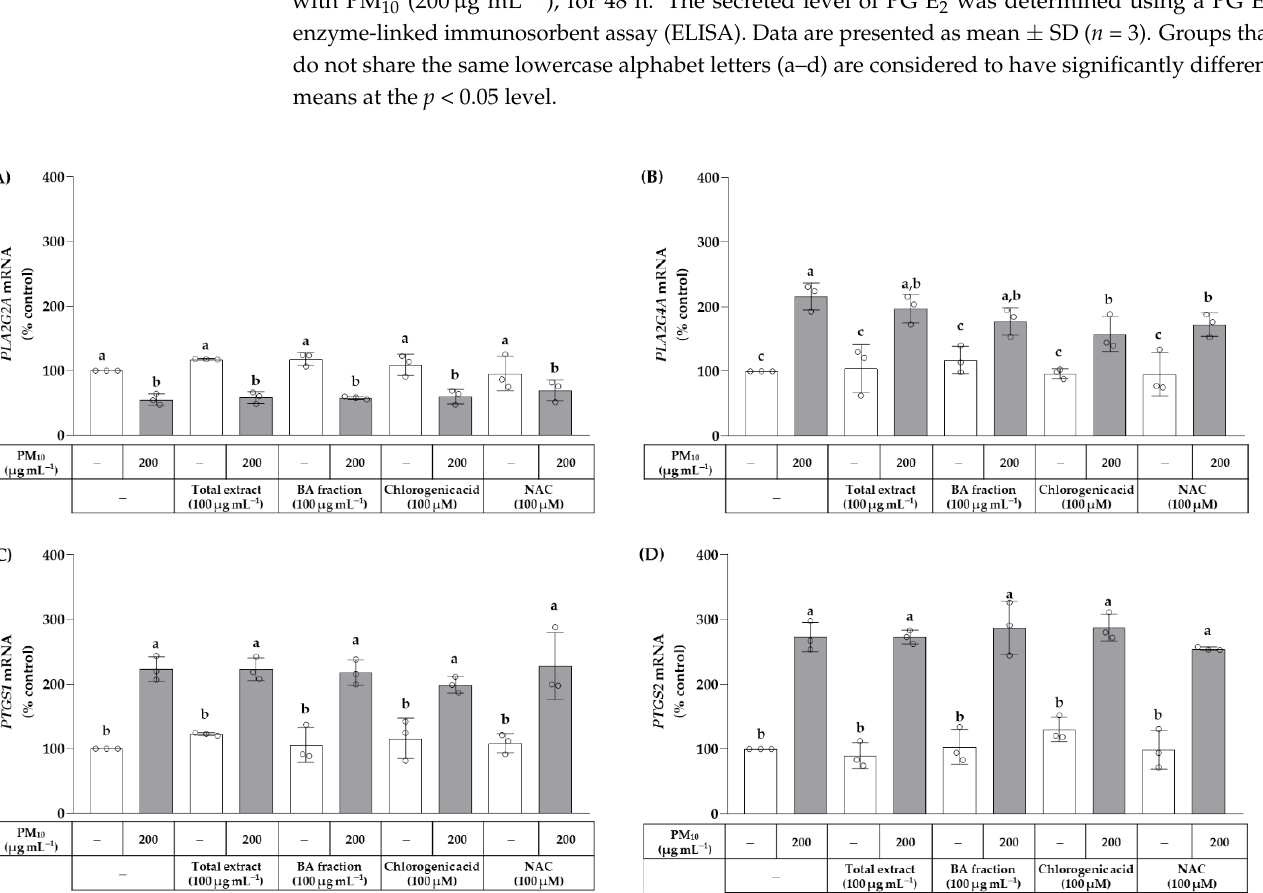
Figure 8. Effects of the total OJ extract, its BA fraction, chlorogenic acid, and NAC on the mRNA expression levels of phospholipase A2 group IIA ( PLA2G2A ) ( A ), phospholipase A2 group IVA ( PLA2G4A ) ( B ), prostaglandin-endoperoxide synthase 1 ( PTGS1 ) ( C ), prostaglandin-endoperoxide synthase 2 ( PTGS2 ) ( D ), prostaglandin E synthetase 1 ( PTGES1 ) ( E ), and prostaglandin E synthetase 2 ( PTGES2 ) ( F ) in HaCaT keratinocytes exposed to PM 10 . Cells were treated with the total extract (100 μg mL −1 ), BA fraction (100 μg mL −1 ), chlorogenic acid (100 μM), and NAC (100 μM), alone or in combination with PM 10 (200 μg mL −1 ), for 24 h. The mRNA expression level of each gene was ana- lyzed by the quantitative reverse transcriptase-polymerase chain reaction (qRT-PCR) and normal- ized to that of glyceraldehyde 3-phosphate dehydrogenase ( GAPDH ). Data are presented as % of control (means ± SD, n = 3). Groups that do not share the same lowercase alphabet letters (a–c) have statistically different means at the p < 0.05 level. The effects of the total OJ extract, BA fraction, chlorogenic acid, and NAC on the pro- tein expression levels of cPLA2 and its phosphorylated active form (phospho-cPLA2) were examined by Western blotting. As shown in Figure 9, PM 10 increased the protein levels of cPLA2 and phospho-cPLA2. The total OJ extract (100 μg mL −1 ), BA fraction (100 μg mL −1 ), chlorogenic acid (100 μM), and NAC (100 μM) did not affect the basal levels of the cPLA2 protein. However, the BA fraction, chlorogenic acid, and NAC lowered the levels of cPLA2 protein under PM 10 -exposed conditions. In addition, chlorogenic acid and